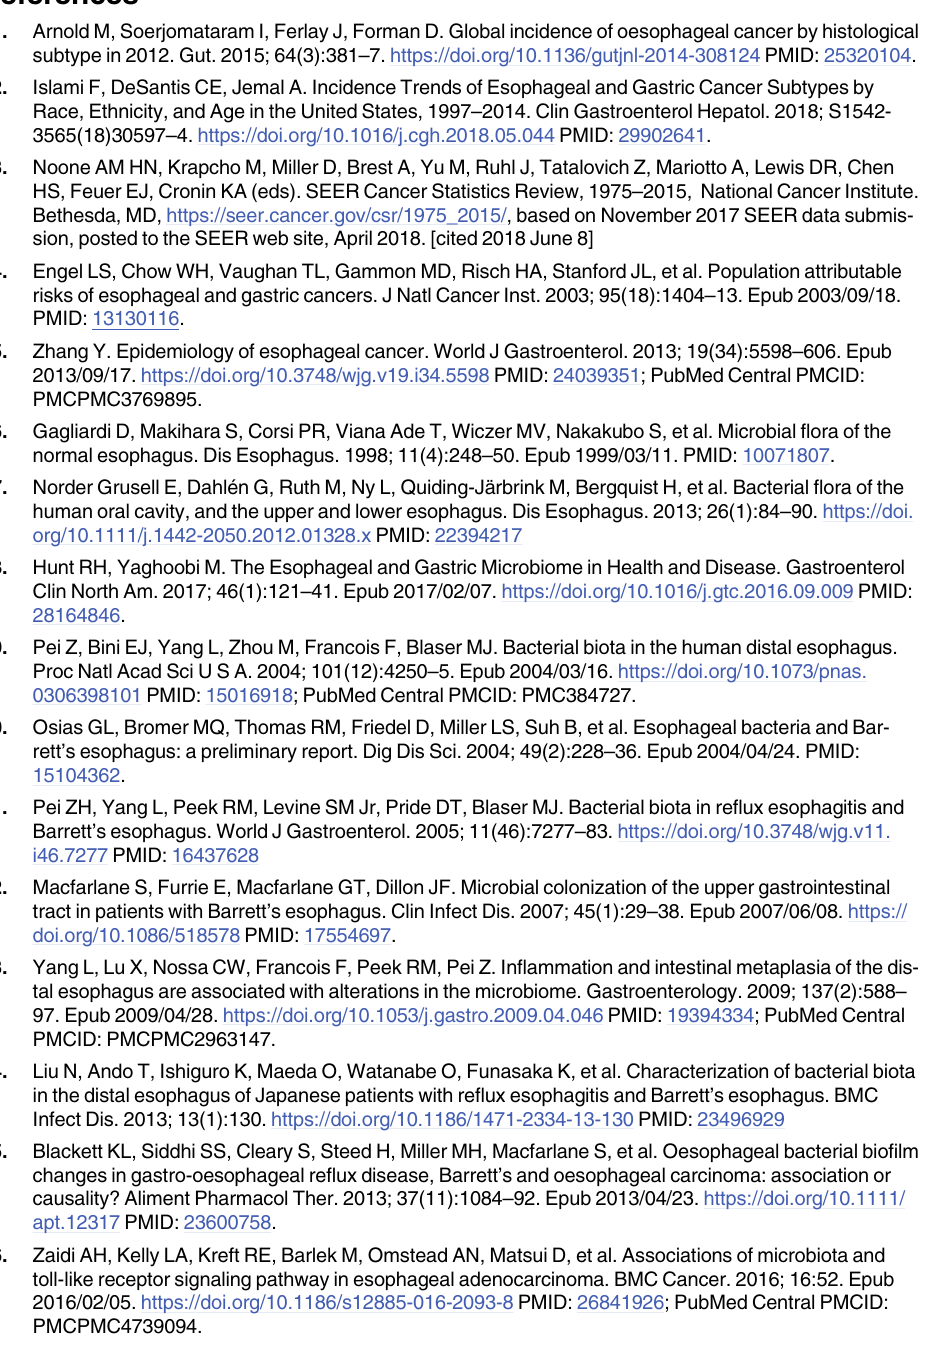
S3 Table. Web of Science database search strategy. S4 Table. Primary studies reporting the characterization of esophageal microbiota in nor- mal and diseased